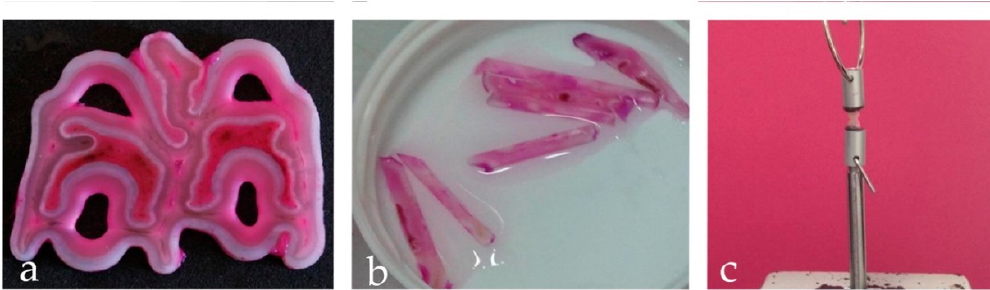
Figure 1. Sample preparation: ( a ) Detail of the crown’s cross section Shift reagent stained. Please note that this staining bonds the organic component highlighting the areas made up of dentin; ( b ) Dentine bars, size 2 × 2 × 8mm. ( c ) Sample mounted on the traction machine.